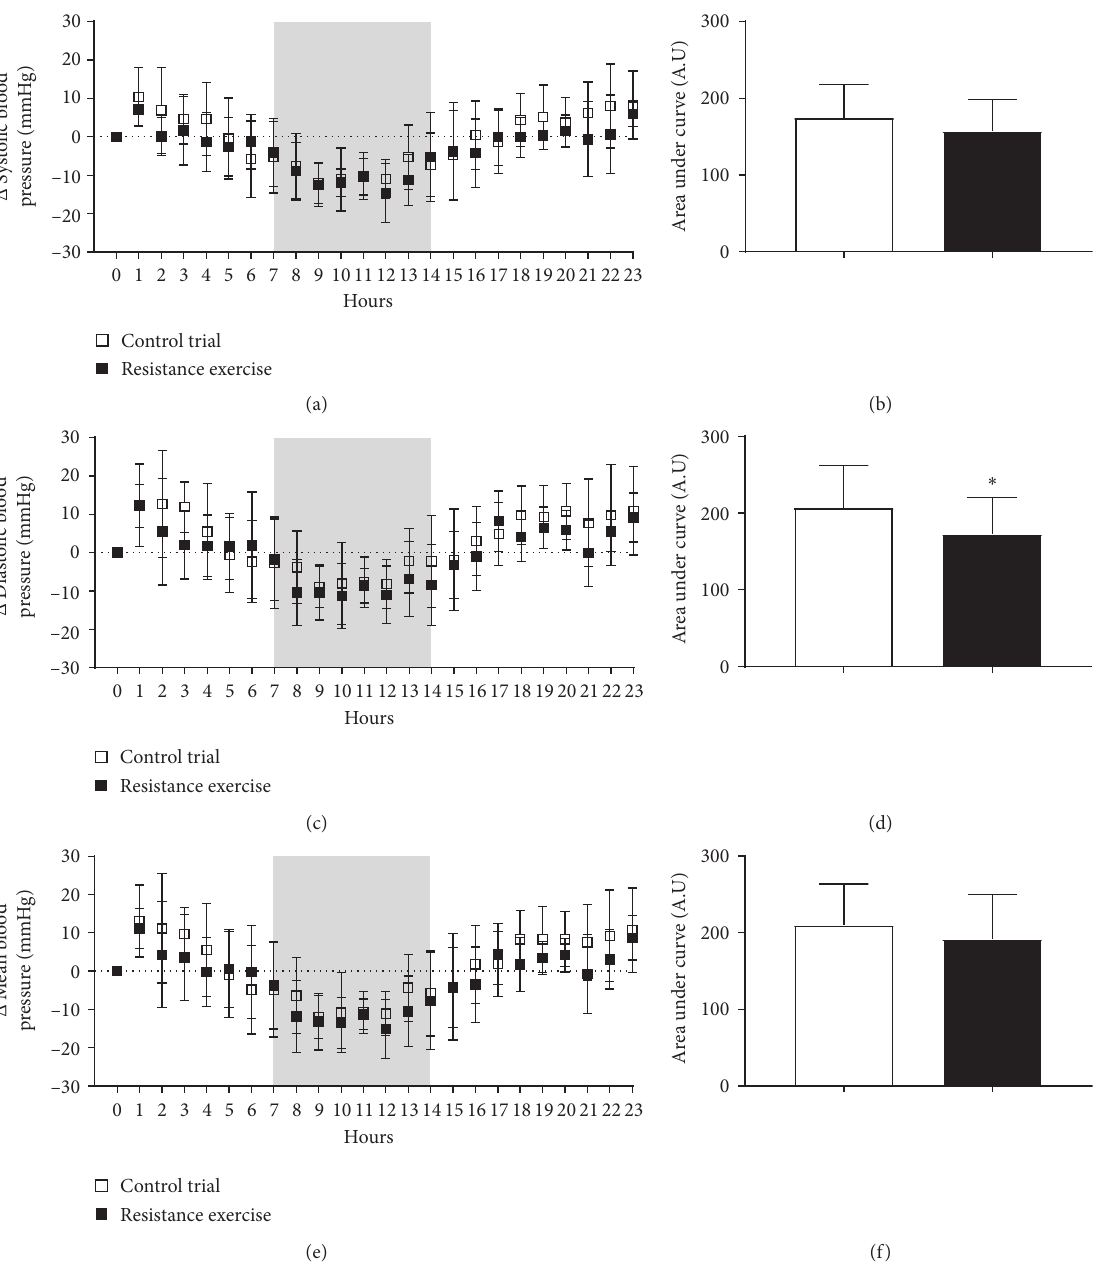
Figure 2: Systolic (A), diastolic (C), and mean BP (E) and respective area under the curve (B, D, and F) monitored 24h after RE and CTR trial. The gray box represents sleep period. ∗ p < 0 . 05 versus CTR